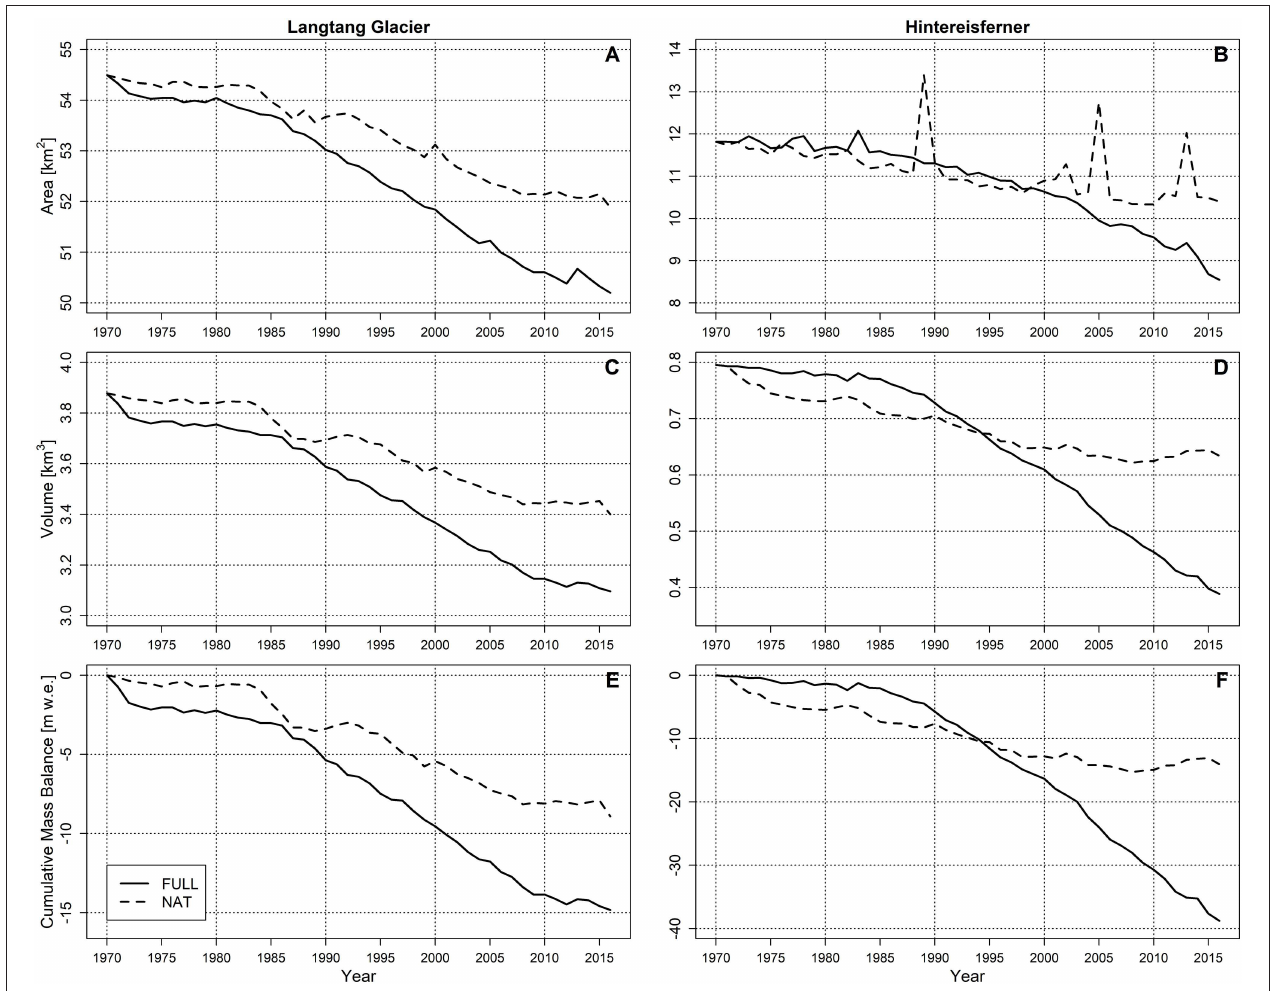
FIGURE 8 | Modeled changes in glacier area (A,B) , volume (C,D) , and specific mass balance (E,F) of the Langtang Glacier (A,C,E) and Hintereisferner (B,D,F) for the cold/wet (Langtang Glacier) and cold/dry (Hintereisferner) FULL (solid) and NATURAL scenarios